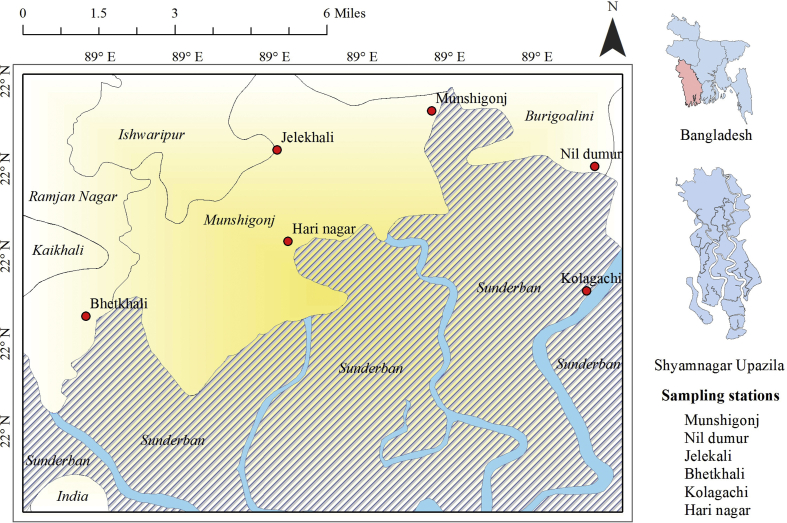
Location of the sampling stations of S. olivacea adjacent to Sundarban mangrove, Bangladesh.